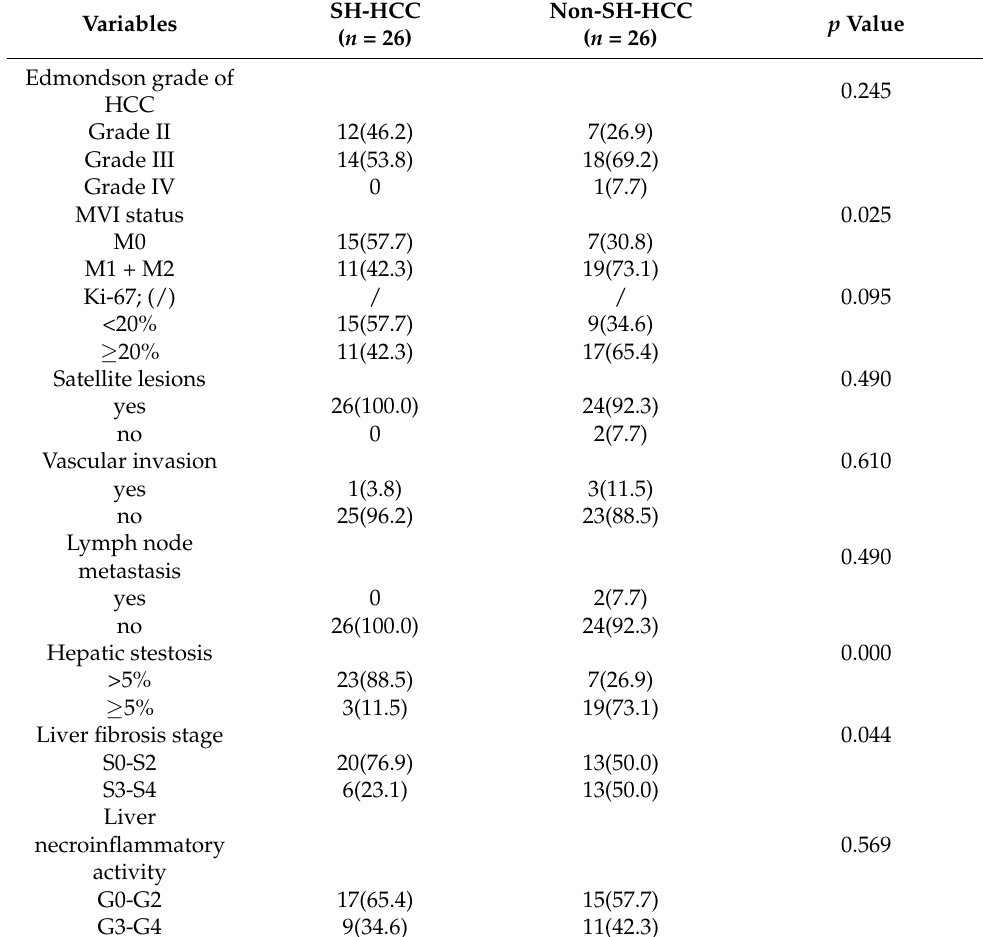
Table 4. Histopathological characteristics of SH-HCCs and non-SH-HCCs (%).